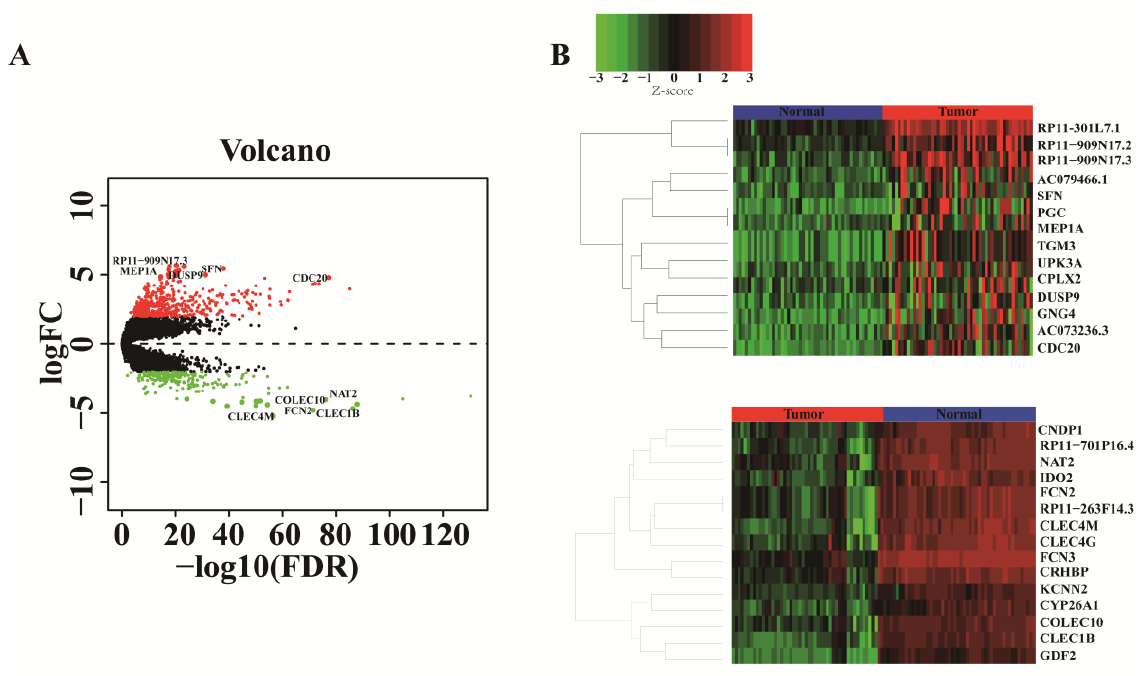
Figure 2. Identification of DEmRNAs in HCC. ( A ) Volcano plot showing the DEmRNAs identified from GSE77314. The points become larger in the top 15 up- and downregulated genes, the top five up- and downregulated gene names are labeled in the volcano. |log2FC| ≥ 2 and a p -value ≤ 0.01 were set as the truncation criteria. ( B ) Heatmap of top 15 up- and downregulated DEmRNAs.